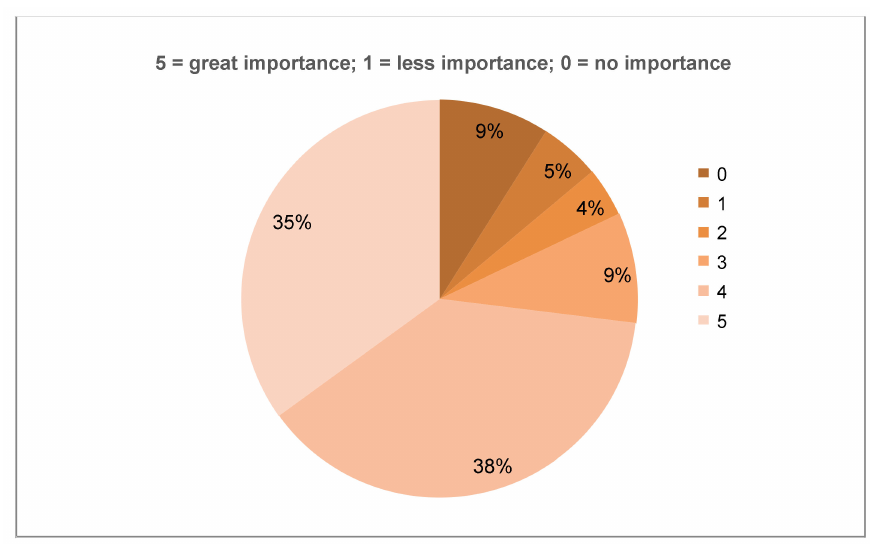
Figure 6. Importance of sustainability in future digitization projects ( n = 85). Table 9. Future topics named by experts in relation to digitization ( n =